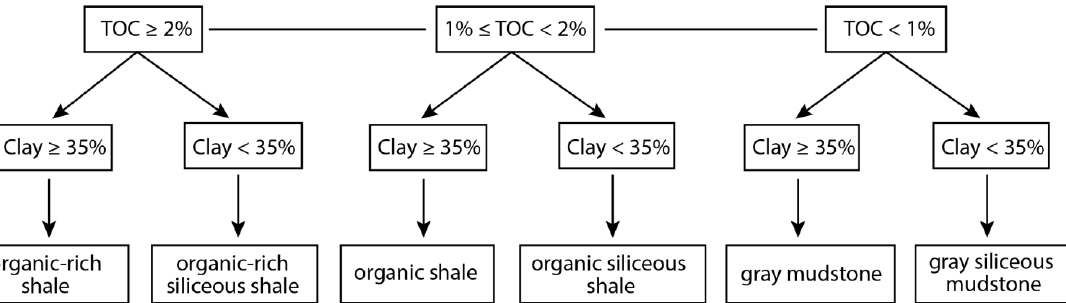
Figure 4. Tree diagram showing the criteria for classifying Gulong Shale lithofacies.